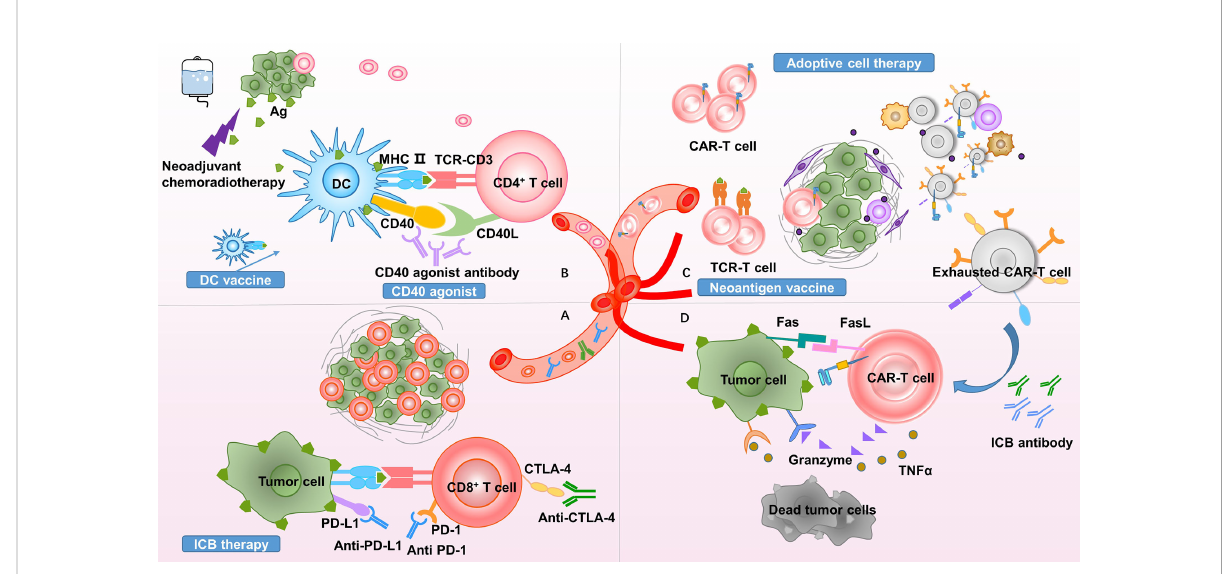
FIGURE 2 Theoretical basis of neoadjuvant combination therapy. Proposed rationales to clarify the promise of neoadjuvant combination therapy. (A) Neoadjuvant therapy increases immunotherapy targets by promoting effector T-cell in fi ltration and increasing ICB antibody delivery. (B) Due to the presence of the tumor burden serving as an antigen source, neoadjuvant therapy promotes antigen presentation and improves responses to CD40 agonists. (C) Neoadjuvant therapy increases the in fi ltration of CAR-T cells and TCR-T cells into the tumor site. The inhibitory TME exhausts T cells, upregulating inhibitory molecular receptors, such as PD-1, TIM-3, and LAG-3. (D) ICB reverses T-cell exhaustion and restores antitumor immunity. PD-1, programmed cell death protein 1; PD-L1, programmed death-ligand 1; CTLA-4, cytotoxic T-lymphocyte-associated antigen 4; MHC, major histocompatibility complex; Ag, antigen; DC, dendritic cell; TCR, T-cell receptor; CAR, chimeric antigen receptor; TIM-3, T-cell immunoglobulin and mucin-domain containing-3; LAG-3, lymphocyte-activation gene 3; ICB, immune checkpoint blockade; TNF, tumor necrosis factor; TME, tumor